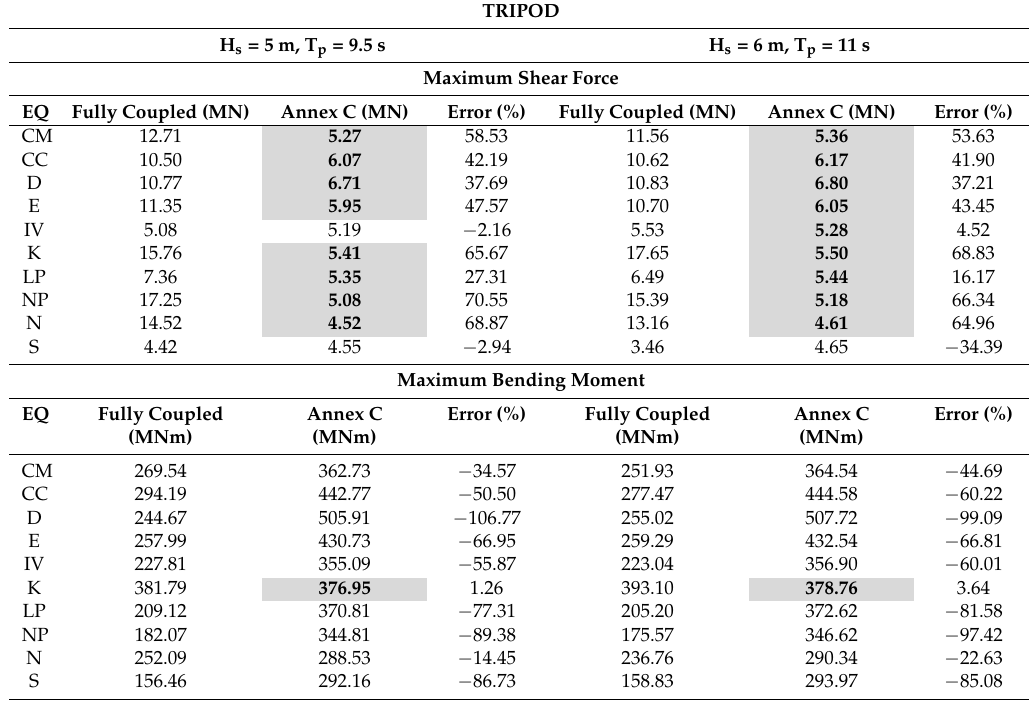
Table 9. Tripod: Shear-force and bending-moment demands at tower base, obtained by Method 3